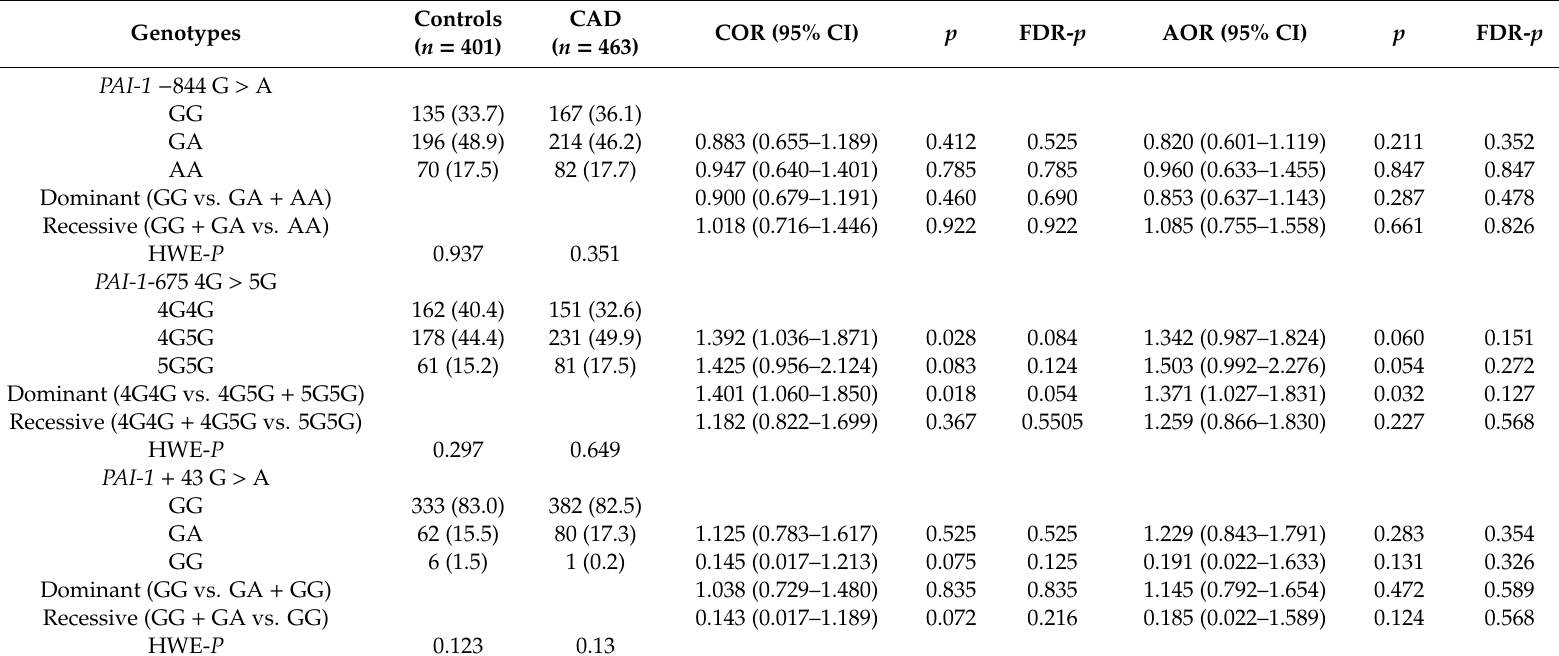
Table 2. Genotype frequencies of PAI-1 polymorphisms in CAD and